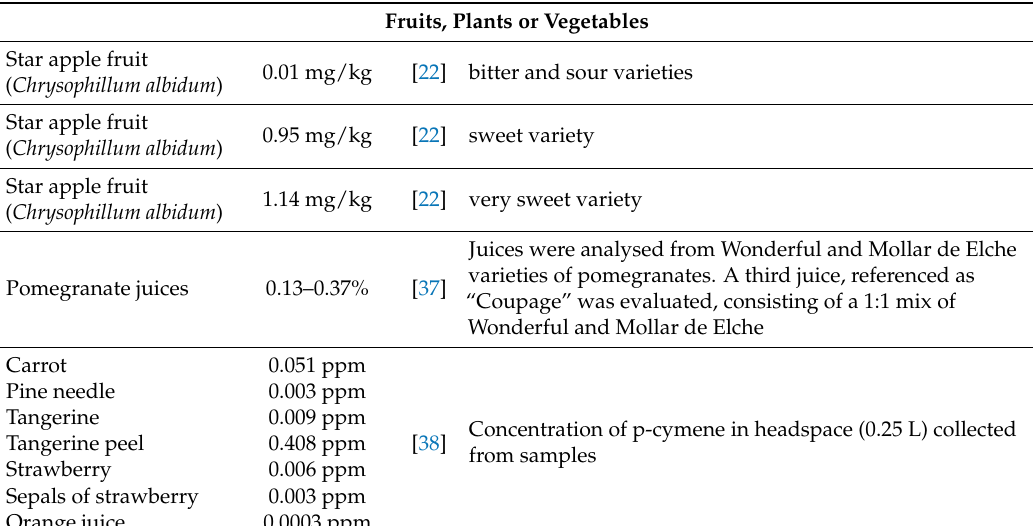
Table 3. p-Cymene levels in some food matrices. Fruits, Plants or